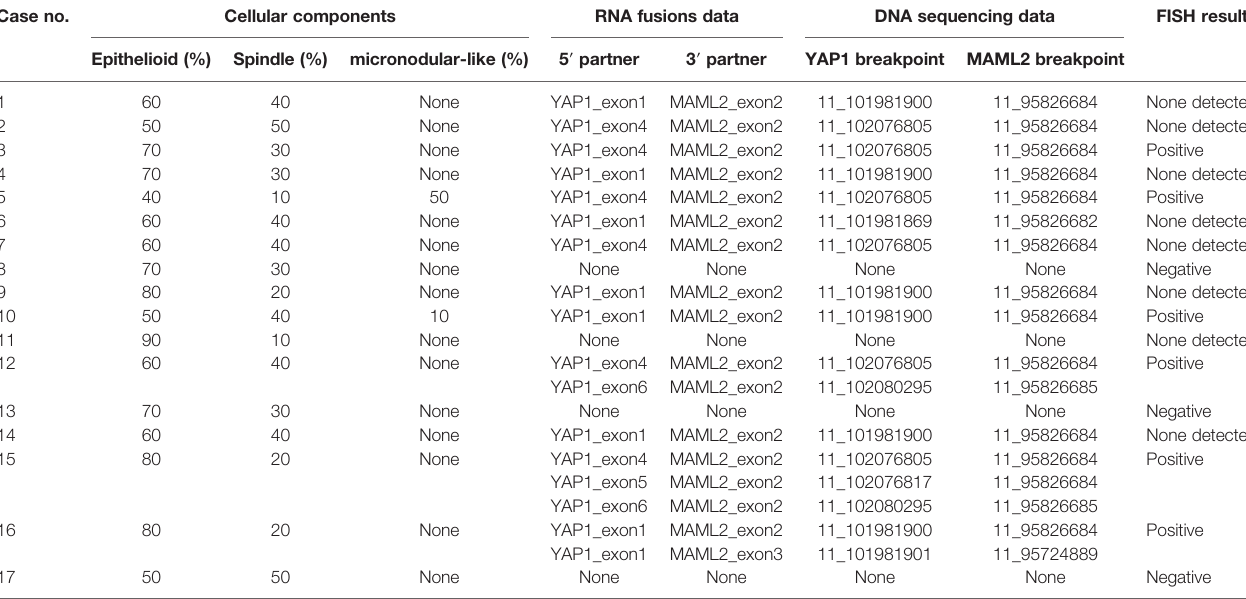
TABLE 2 | Uni fi ed RNA and DNA NGS Assay and FISH detection of YAP1-MAML2 fusions in 17 metaplastic thymoma cases. Case no. Cellular components RNA fusions data DNA sequencing data FISH